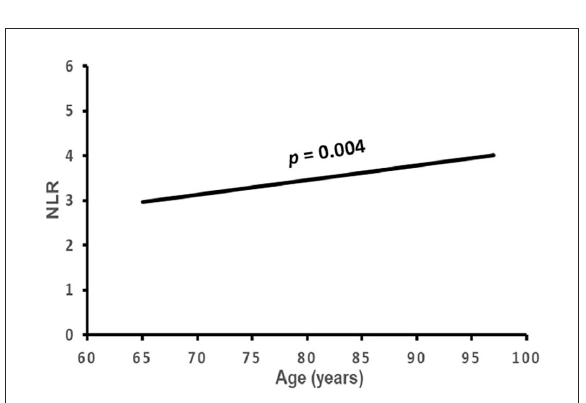
FIGURE3 The association of NLR with age. NLR, neutrophil to lymphocyte ratio.